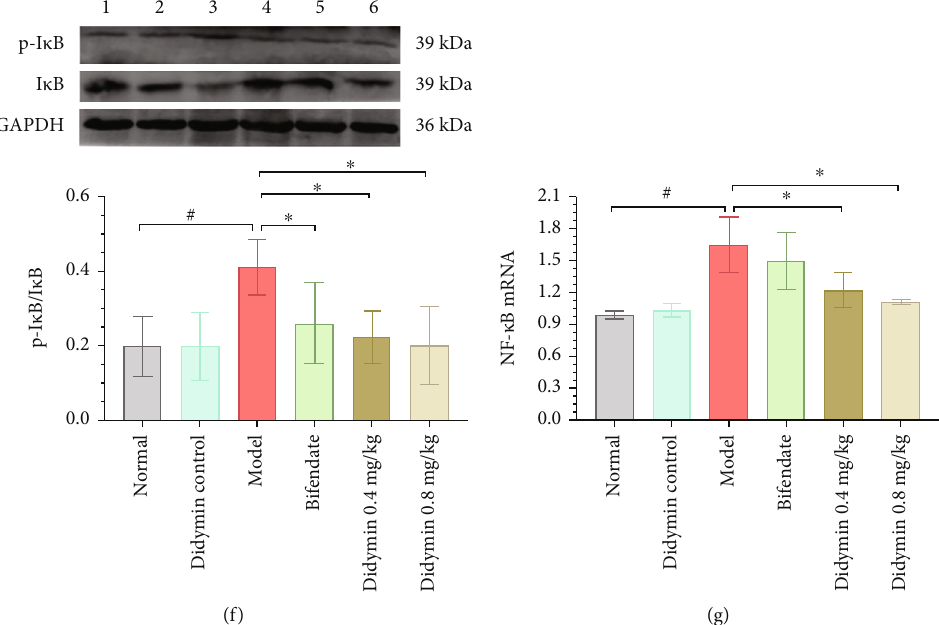
Figure 7: Didymin inhibited the TLR4/NF- κ B pathway. (a) The immunohistochemical analysis of NF- κ B (400x). (b – f) The expressions of TLR4, MyD88, NF- κ B, p-IKK α / β /IKK α / β , and p-I κ B α /I κ B α were determined by western blot. (g) The mRNA level of NF- κ B was detected by qPCR assays. The bands 1 to 6, respectively, represent the normal control group, didymin control group, model group, bifendate-treated group, and low- and high-dosages of didymin-treated groups. The data are presented as mean ± SD . # P < 0 : 05 vs. the normal group; ∗ P < 0 : 05 vs. the model